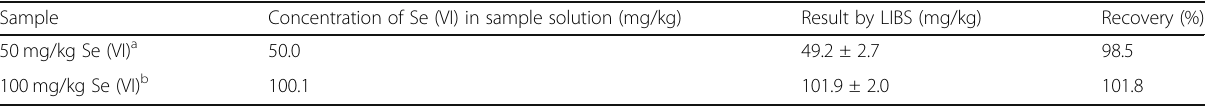
Table 1 Determination of Se (VI) in pH 7 Sample